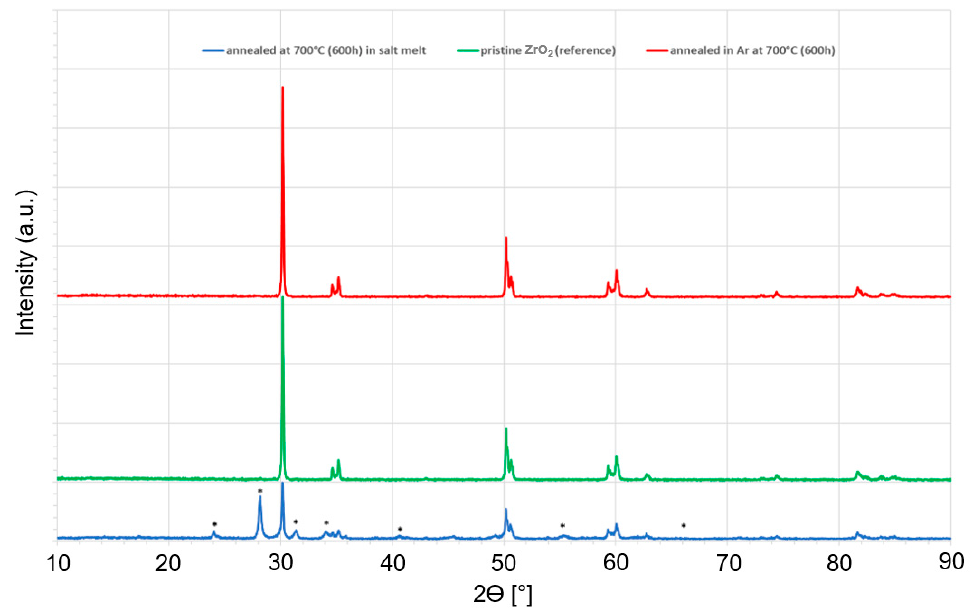
Figure 4. XRD analysis of 3D-printed ZrO 2 in three states: annealed at 700 °C (600 h) in salt melt, pristine ZrO 2 serving as reference and annealed in Ar at 700 °C (600 h). All peaks were assigned to tetragonal tazheranite syn (PDF 01-072-7115), except the ones marked with an asterisk, which were assigned to monoclinic baddeleyite syn (PDF 01-081-1314) for the sample annealed at 700 °C (600 h) in salt melt.